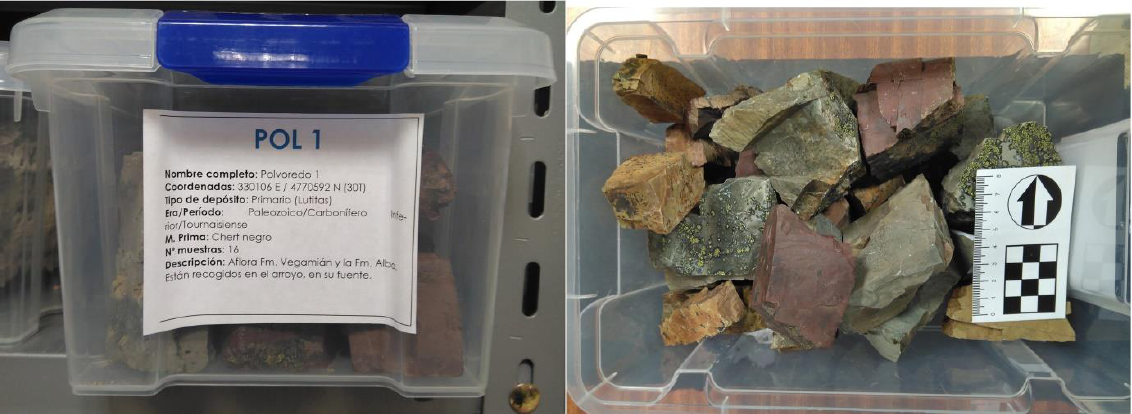
Figure 3: Samples from one of the studied outcrops, stored in their box and showing the high variability of the external features of the samples from a single